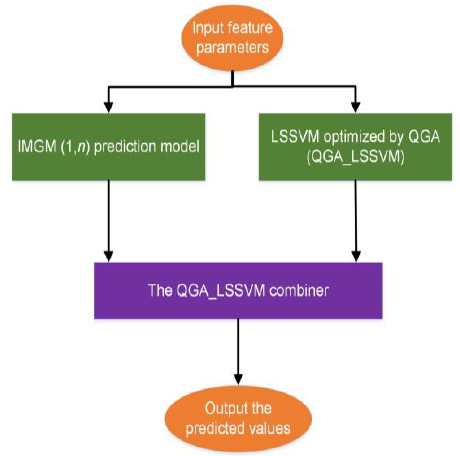
Figure 3. The flow chart of combined prediction.